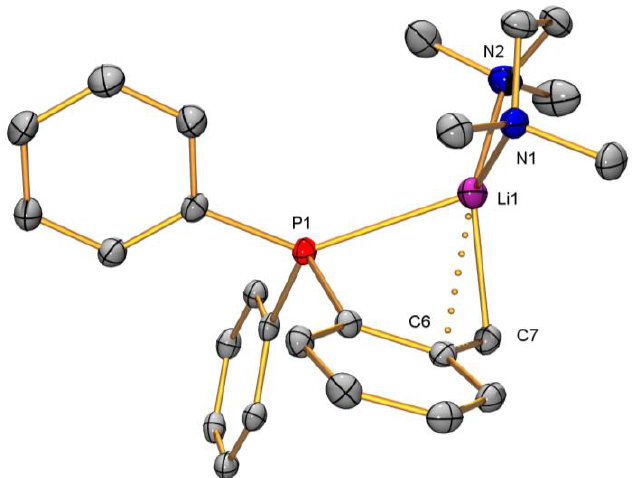
Figure 1. Molecular structure of 1-Li showing thermal ellipsoids at 50% probability (all the hydrogen atoms were omitted for clarity). Selected bond lengths (Å ) and angles (°): P1-Li1 2.637(3), N1-Li1 2.068(3), N2-Li1 2.069(7), C7-Li1 2.206(3), C6-Li1 2.555(3), C7-C6 1.409(2), N1-Li1-N2 88.42(12), C7-Li1-P1 76.51(10), N1-Li1-P1 116.74(13), N2-Li1-P1 118.48(13), N2-Li1-C7 136.95(16), N1-Li1-C7 122.41(15), C6-Li1-P1 64.04(7).